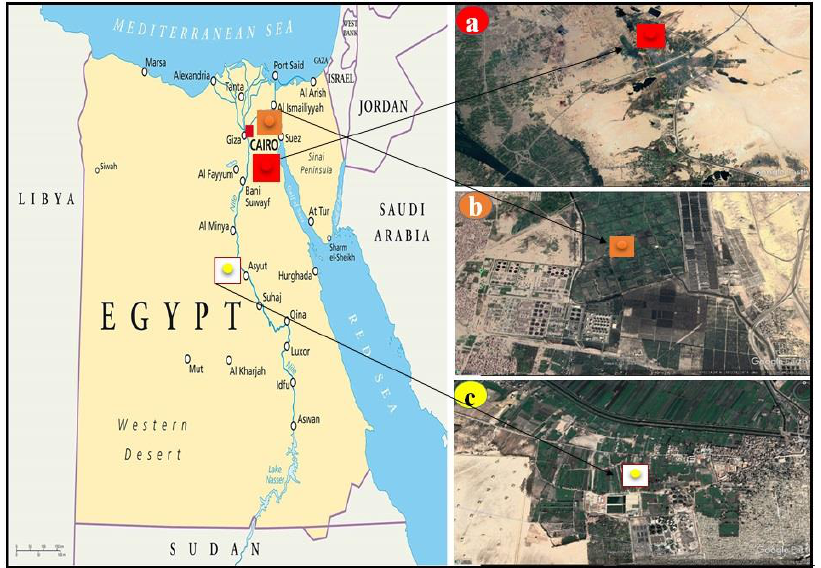
Figure 1. An aerial map of Egypt showing the location of the Helwan ( a ) El-Gabal El-Asfar ( b ) and El-Madabeg ( c ) soils scene acquired from Google Earth. 2020. The collected soil samples were air-dried, ground with a wooden roller, sieved to pass through a 2 mm sieve, and kept for experimental purposes. Available Pb, Zn and Cu were extracted from the soil samples using a 0.005 M of diethylene triamine pentaacetic acid (DTPA) solution buffered at pH 7.3 as described by [37]. A soil sample of 1 g was used to extract metal content using HNO 3 , H 2 O 2 , and HCl [38]. Certain physical properties, soil reaction (pH), soil salinity (EC), and soil organic matter of tested soils were measured according to [39] with three replicates for each and are presented in Table 1. Table 1. Some chemical and physical properties of the studied